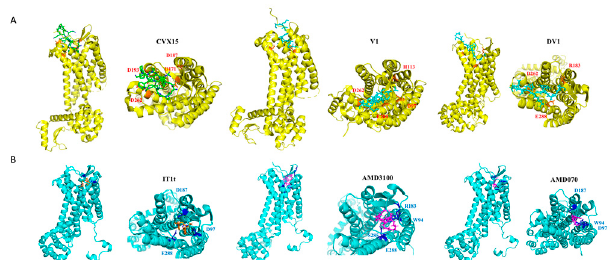
Figure 6. Binding models of diverse CXCR4 ligands from molecular docking or crystallography. ( A ) Binding poses of peptidic inhibitors CVX15, N-terminus of V1 and DV1 by side view and pocket view (presented in green, aquamarine and cyan respectively). ( B ) Binding poses of small-molecule inhibitors IT1t, AMD3100 and AMD070 by side view and pocket view (presented in orange, magenta and purple respectively).